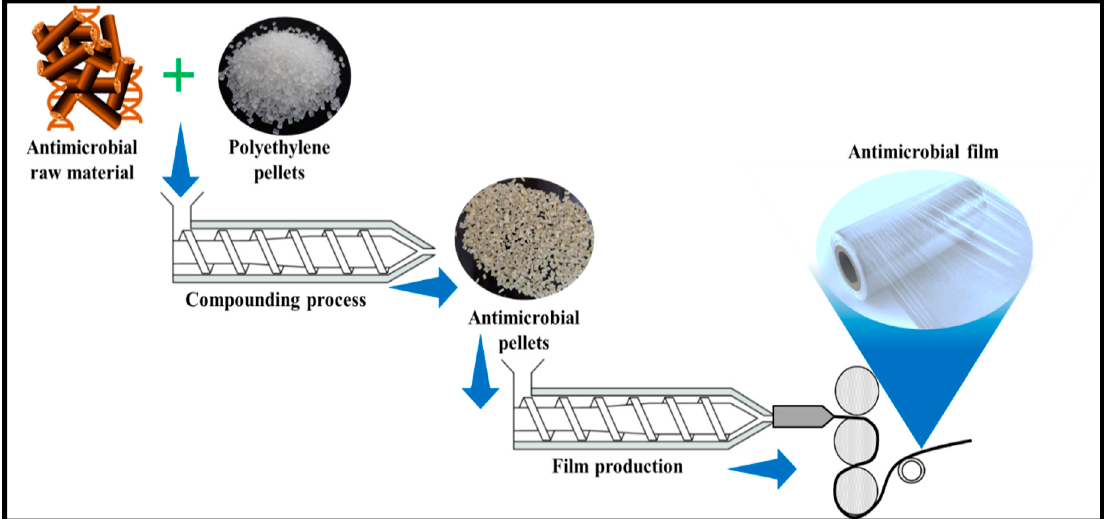
Figure 6. Production of antimicrobial film from antimicrobial raw